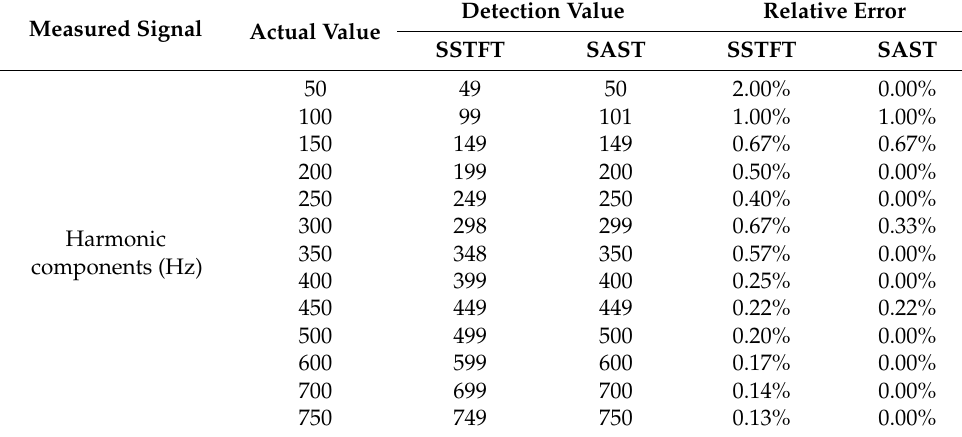
Table 6. Accuracy of two methods in detecting wind power grid-connected harmonics. Detection Value Relative Error Measured Signal Actual Value SSTFT SAST SSTFT SAST